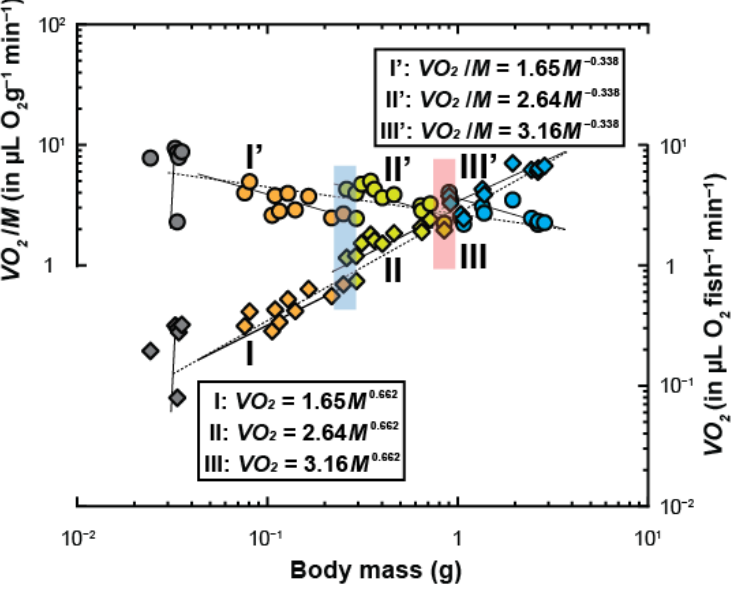
Figure 1. Changes in oxygen consumption ( VO 2 , closed rhombi) and mass-specific rates of oxygen consumption ( VO 2 / M , closed circles) according to the body mass ( M ) of F 2 bester ( Huso huso × Acipenser ruthenus ) from the prolarval stage to early juvenile stage (from 0.0243 g [wet body mass, 4-day-old] to 2.8647 g [wet body mass, 65-day-old]; N = 40). Vertical black lines at about 0.03 g indicate VO 2 and VO 2 / M , which increased daily 4–16-day-old, despite almost no change in body mass. Intragroup phases of negative allometry are denoted by the ranges spanned by three solid black lines for VO 2 and VO 2 / M , respectively. The blue and red boxes indicate the intermediate phase shifting points, i.e., transitional phases with ranges covered by the overlapping solid lines, at about 0.2 and 0.8 g, respectively. Intergroup lines without transitional phases are shown as broken black lines for VO 2 and VO 2 / M , respectively.